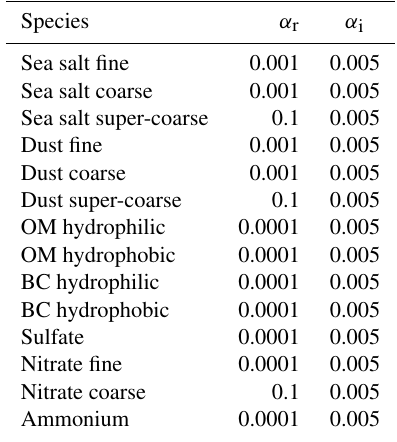
Table 8. Value of the parameters α r and α i